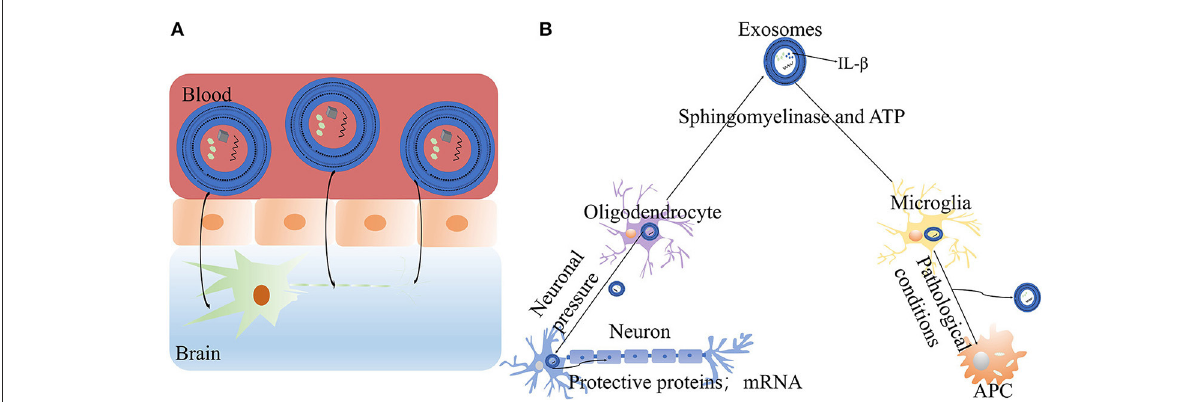
FIGURE3 The mechanisms of exosomes in PD: (A) Exosomes can freely cross the blood-brain barrier, reach the central nervous system and exert therapeutic effects. (B) The roles of exosomes in neurons and cells: exosomes released by oligodendrocytes promote neuroprotection (ATP, adenosine-triphosphate; IL- β , Interleukin-1 β